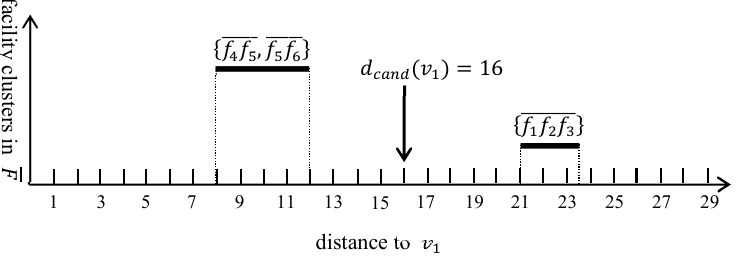
Figure 10. Arrangement of the facility clusters based on their largest distance to v 1 . Table 2. Summary of the computation of the candidate facilities for v 1 v 2 .